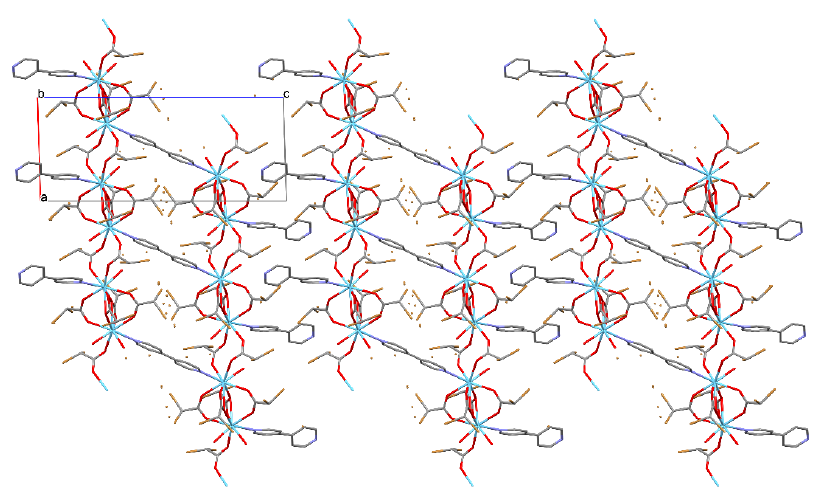
Figure 7. Packing of the molecules in the crystal of compound 1 along the b axis. The orange dots are disordered sites of Br atoms.